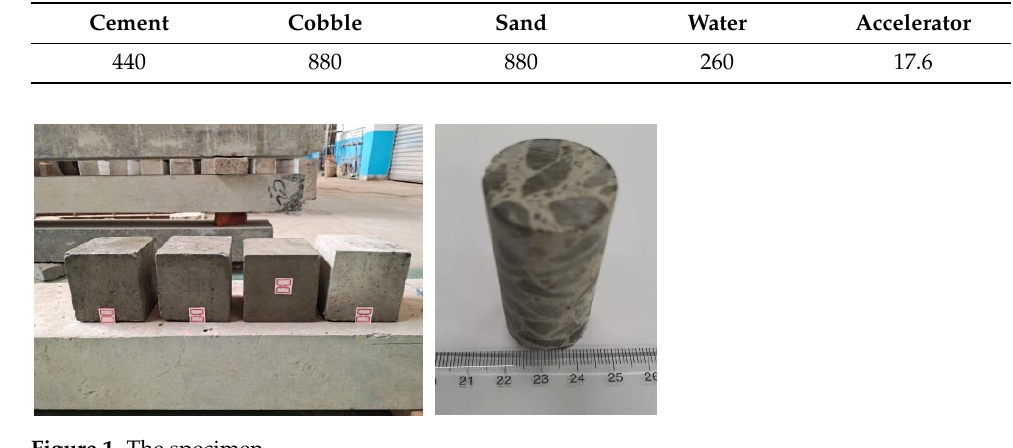
Figure 1. The specimen.